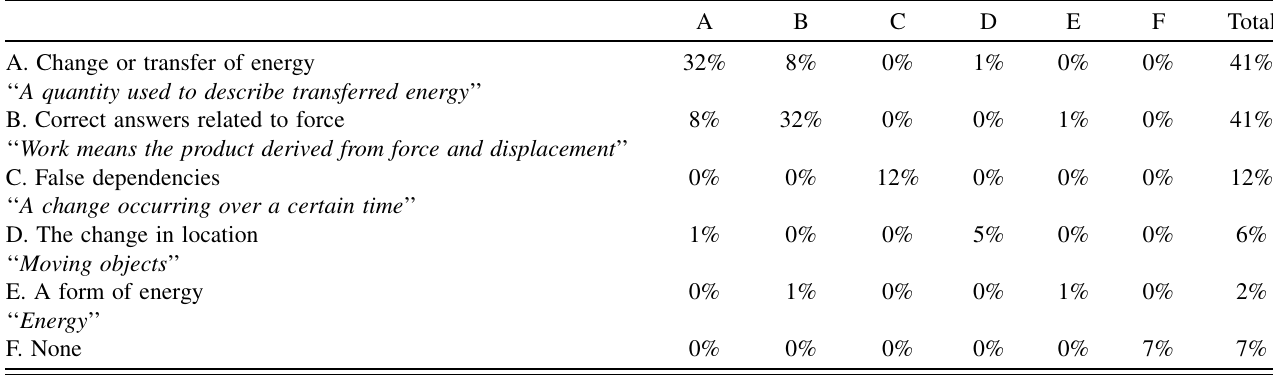
TABLE IV. Categorization of students’ conceptions of work. Categories A–E refer to the same categories in rows and columns. N ¼ 75 . A typical example from each category is presented after the category symbol in